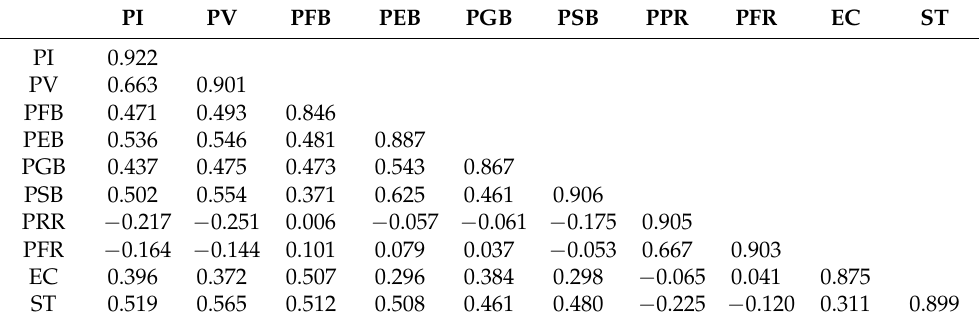
Table 4. Correlation coefficient matrix and square roots of average variances extracted (AVEs).